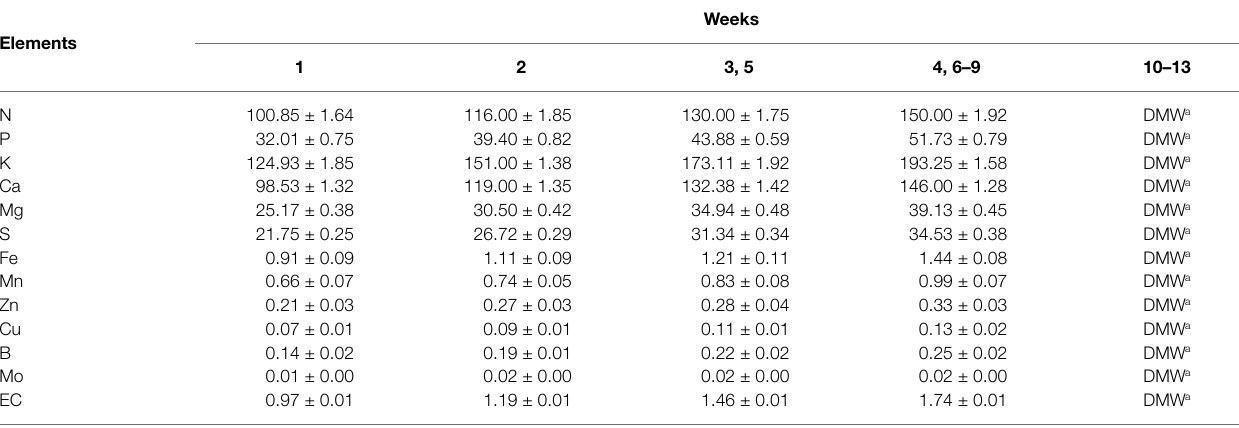
TABLE 2 | Composition of control treatment (CN) nutrient solution (mg/L).